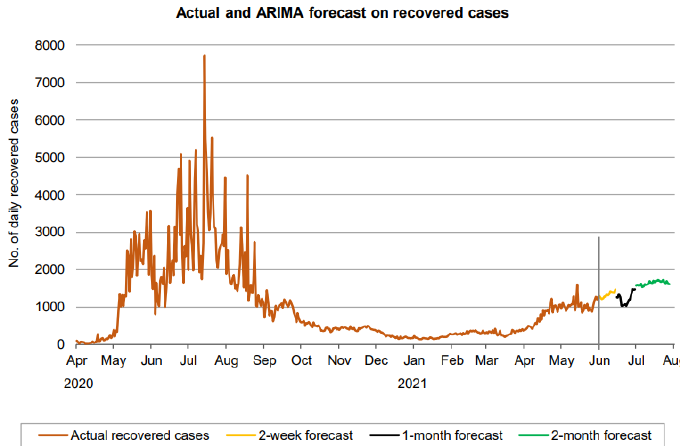
Figure 12. Prediction over a 60-day forecast for the recovered cases using the ARIMA